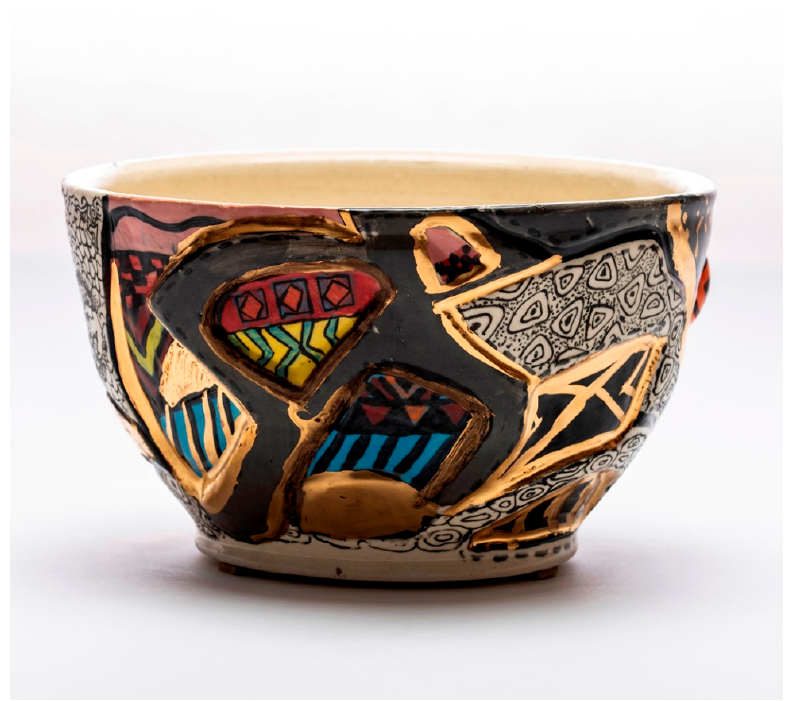
Figure 8. Stunting: Pump I, 2018 , Porcelain, china paint, luster, 5 × 10 × 10 in. Image by KeneK Photography, courtesy of Wexler Gallery.